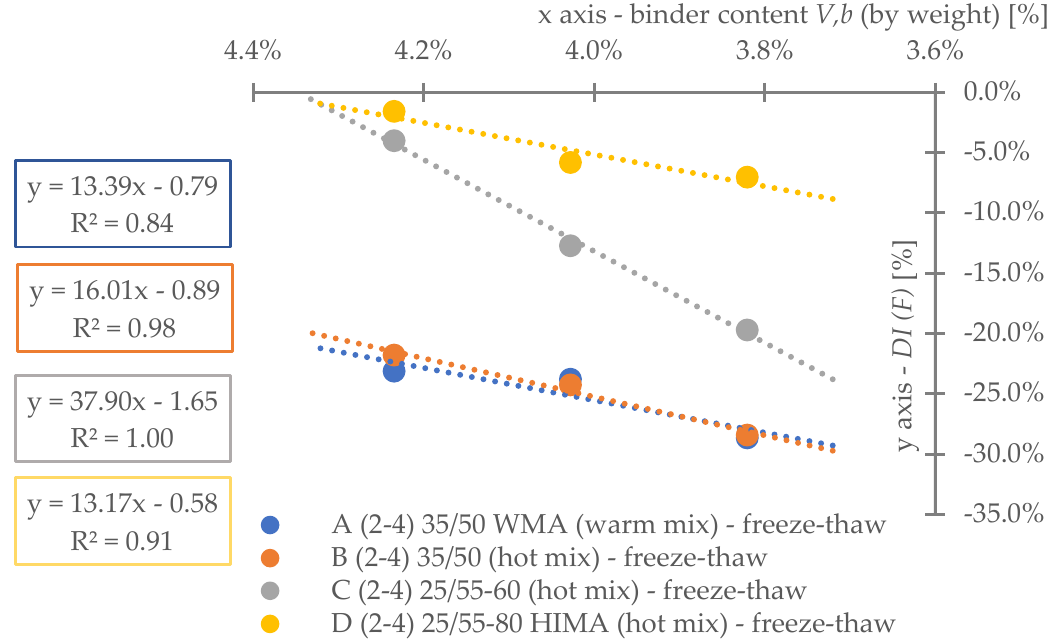
Figure 10. Degradation ratio variability (fatigue) through all mixes (water-frost). asphalt mixture binder type and its content level. 𝐷𝐼 (𝐹) ratio differs from 1.56% (D2,